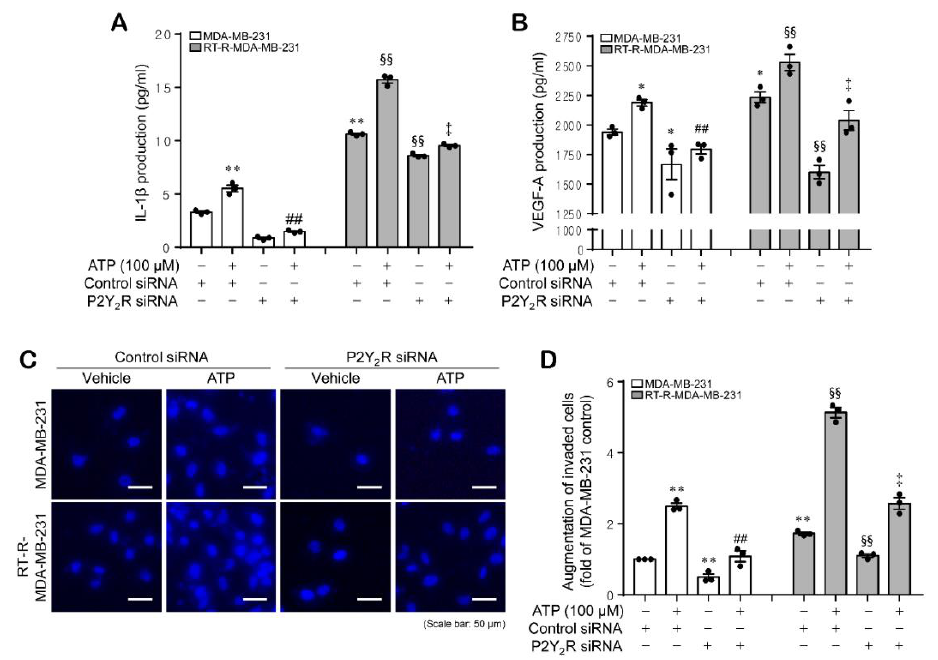
Figure 3. Inflammasome activation induced by ATP increased the secretion of interleukin (IL)-1 β and vascular endothelial growth factor (VEGF)-A and the invasive ability of MDA-MB-231 and RT-R-MDA-MB-231 cells in a P2Y 2 R-dependent manner. ( A , B ) Control or P2Y 2 R siRNA-transfected cells were stimulated with ATP (100 µ M) for 24 h. Then, IL-1 β ( A ) and VEGF-A production ( B ) were measured as described in the Methods section. The values represent the mean ± SEM of three independent experiments. * p < 0.05, ** p < 0.01, compared to the control MDA-MB-231 cells; ## p < 0.01, compared to ATP-treated MDA-MB-231 cells; §§ p < 0.01, compared to the control RT-R-MDA-MB-231 cells; ‡ p < 0.01, compared to ATP-treated RT-R-MDA-MB-231 cells. ( C , D ) Control or P2Y 2 R siRNA-transfected cells were stimulated with ATP (100 µ M) for 24 h. Then, Matrigel invasion assays were performed as described in the Methods section. The invaded cells that crossed the membrane were stained with 4 (cid:48) ,6-diamidine-2 (cid:48) -phenylindole dihydrochloride (DAPI) ( C ) and counted in three randomly selected fields under a fluorescence microscope ( D ). The values represent the mean ± SEM of three independent experiments. ** p < 0.01, compared to the control MDA-MB-231 cells; ## p < 0.01, compared to ATP-treated MDA-MB-231 cells; §§ p < 0.01, compared to the control RT-R-MDA-MB-231 cells; ‡ p < 0.01, compared to ATP-treated RT-R-MDA-MB-231 cells. Scale bar: 50 µ